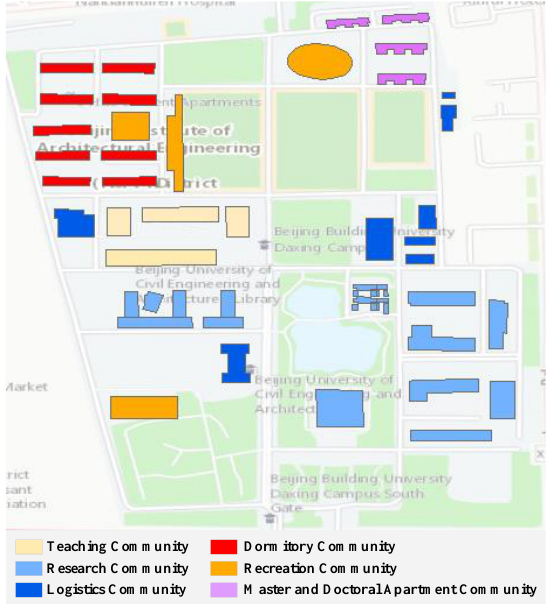
Figure 1. Study area is a university in